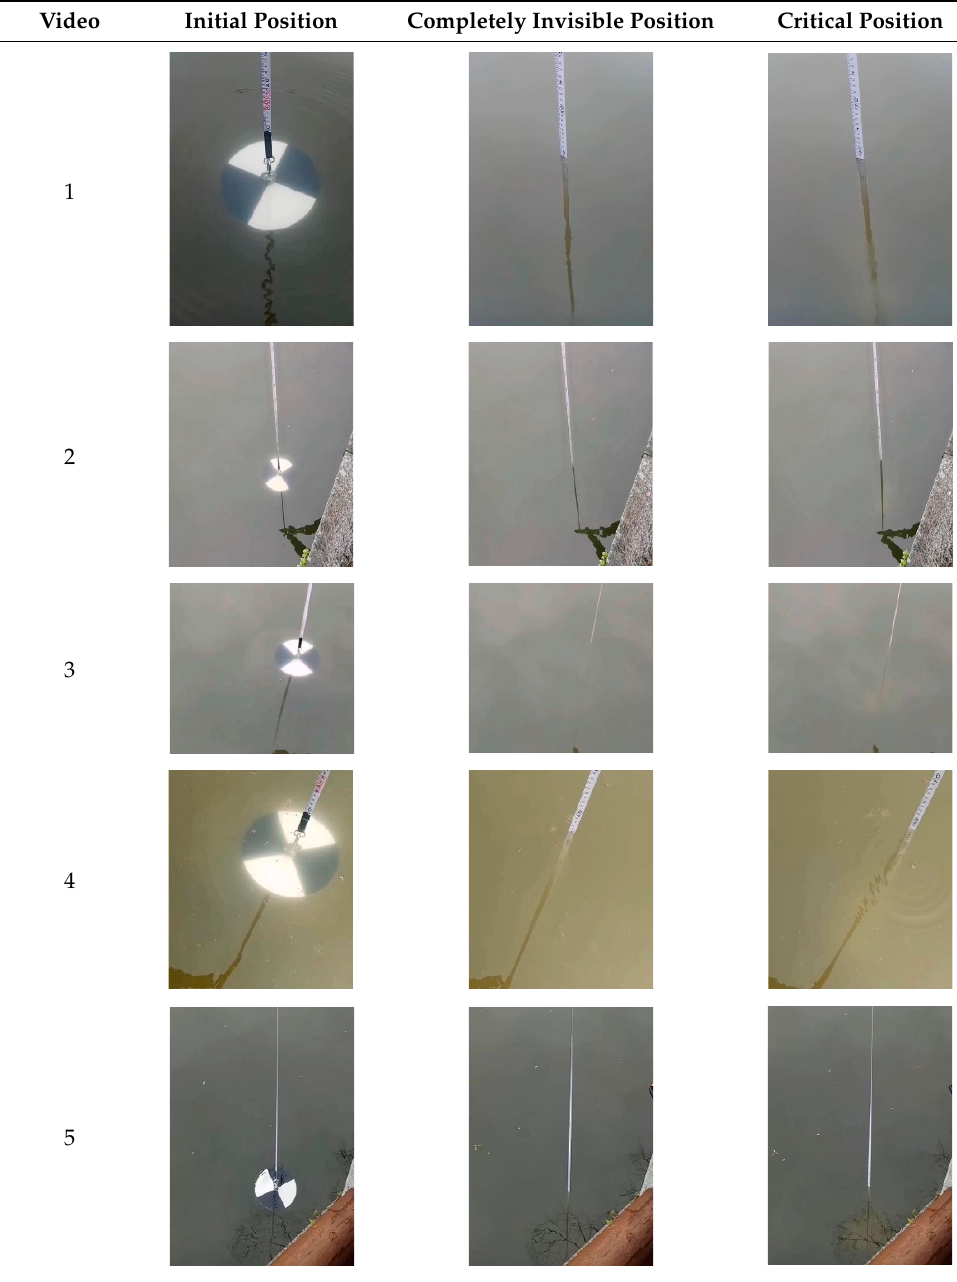
Table 3. Test results of critical position determination by classification network.